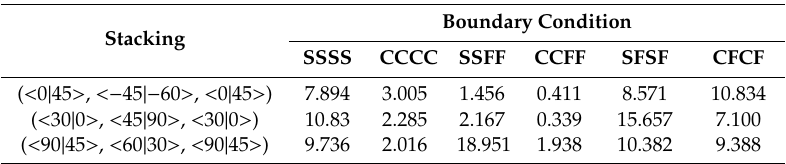
Table 7. Maximum transverse deflection [mm] for the three-layer configurations of variable sti ff ness (VS)